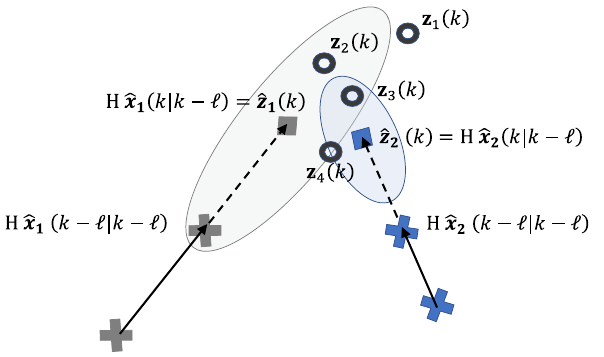
Figure 3: Example of validation regions. The four latest detections ( the circles ) and the elliptic validation regions of two paths. The crosses denote the path estimates updated by their associated detections and the predicted path positions based are shown with